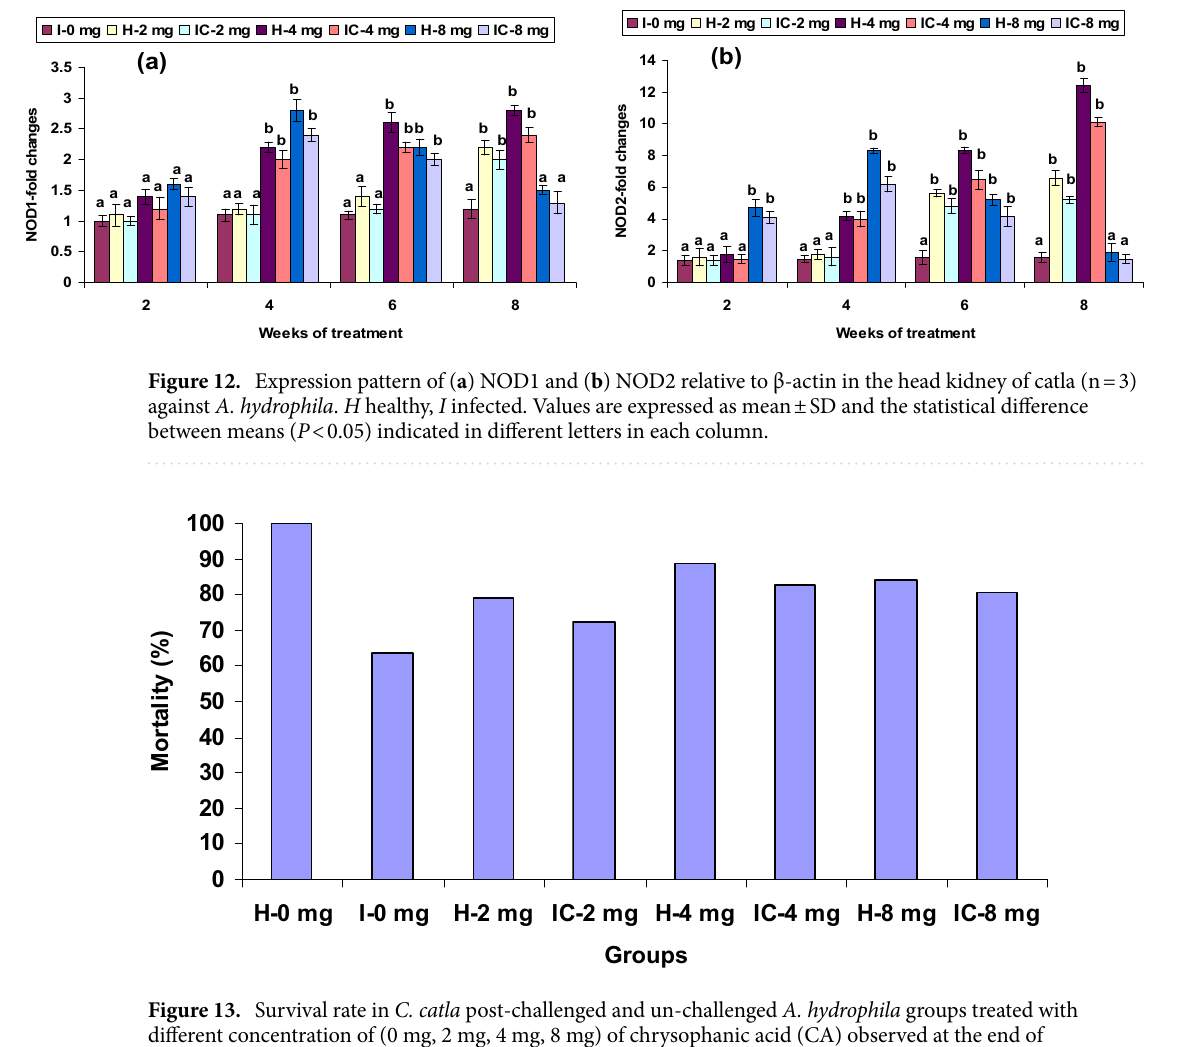
Figure 13. Survival rate in C. catla post-challenged and un-challenged A. hydrophila groups treated with different concentration of (0 mg, 2 mg, 4 mg, 8 mg) of chrysophanic acid (CA) observed at the end of experiment. H healthy, I